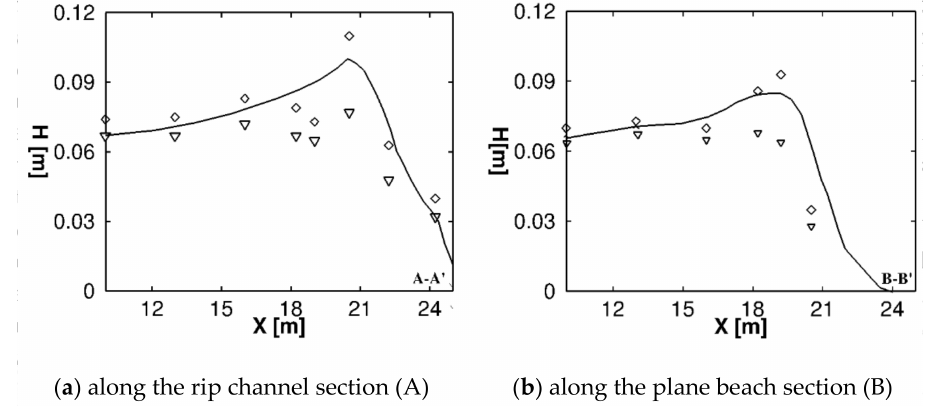
Figure 2. Wave height comparison between the numerical results (solid line) obtained with the proposed model and the experimental data (diamonds represent the experimental data for significant wave height H 1/3 and gradients represent the experimental data for variance-based wave height H σ / from Hamm